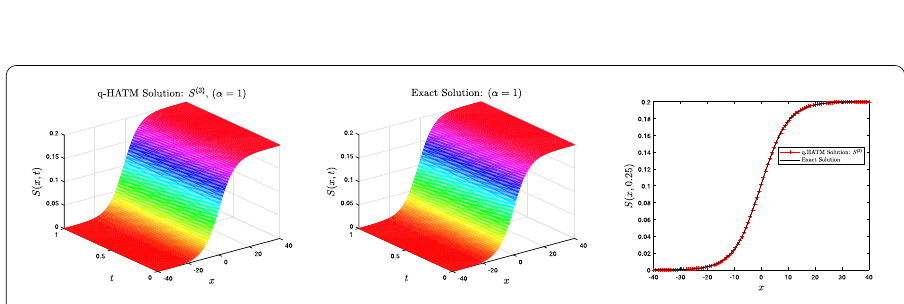
Figure 8 q-HATM vs exact solution when (cid:2) = –1, k = r = 0.1, λ = 1.5, and n = 1 for Example 4.2